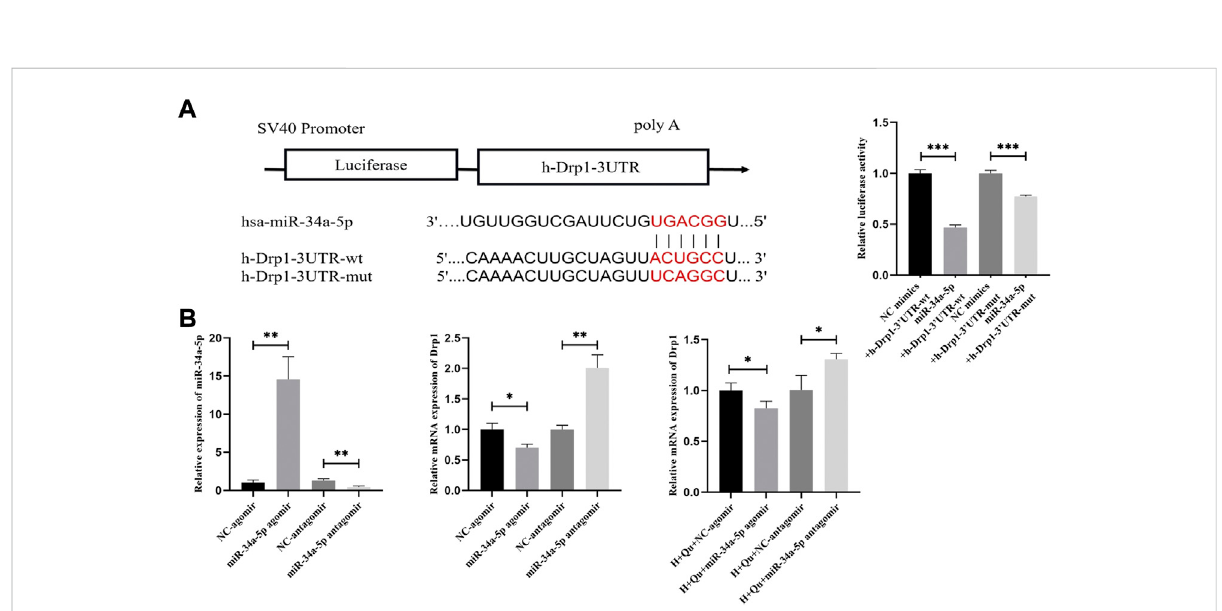
FIGURE 8 TheroleofmiR-34a-5pinquercetinregulationonDrp1. (A) ThebindingsitesbetweenDrp1andmiR-34a-5p;LuciferaseactivityassaysofDrp1- 3 ′ UTR-wt and Drp1-3 ′ UTR-mut with or without miR-34a-5p overexpression. (B) Expression of miR-34a-5p and Drp1 in HTR-8/SVneo cells by qRT- PCR analysis; Expression of Drp1 in HTR-8/SVneo cells under hypoxia with quercetin pretreatment by qRT-PCR analysis. n = 3, * p < 0.05, ** p <